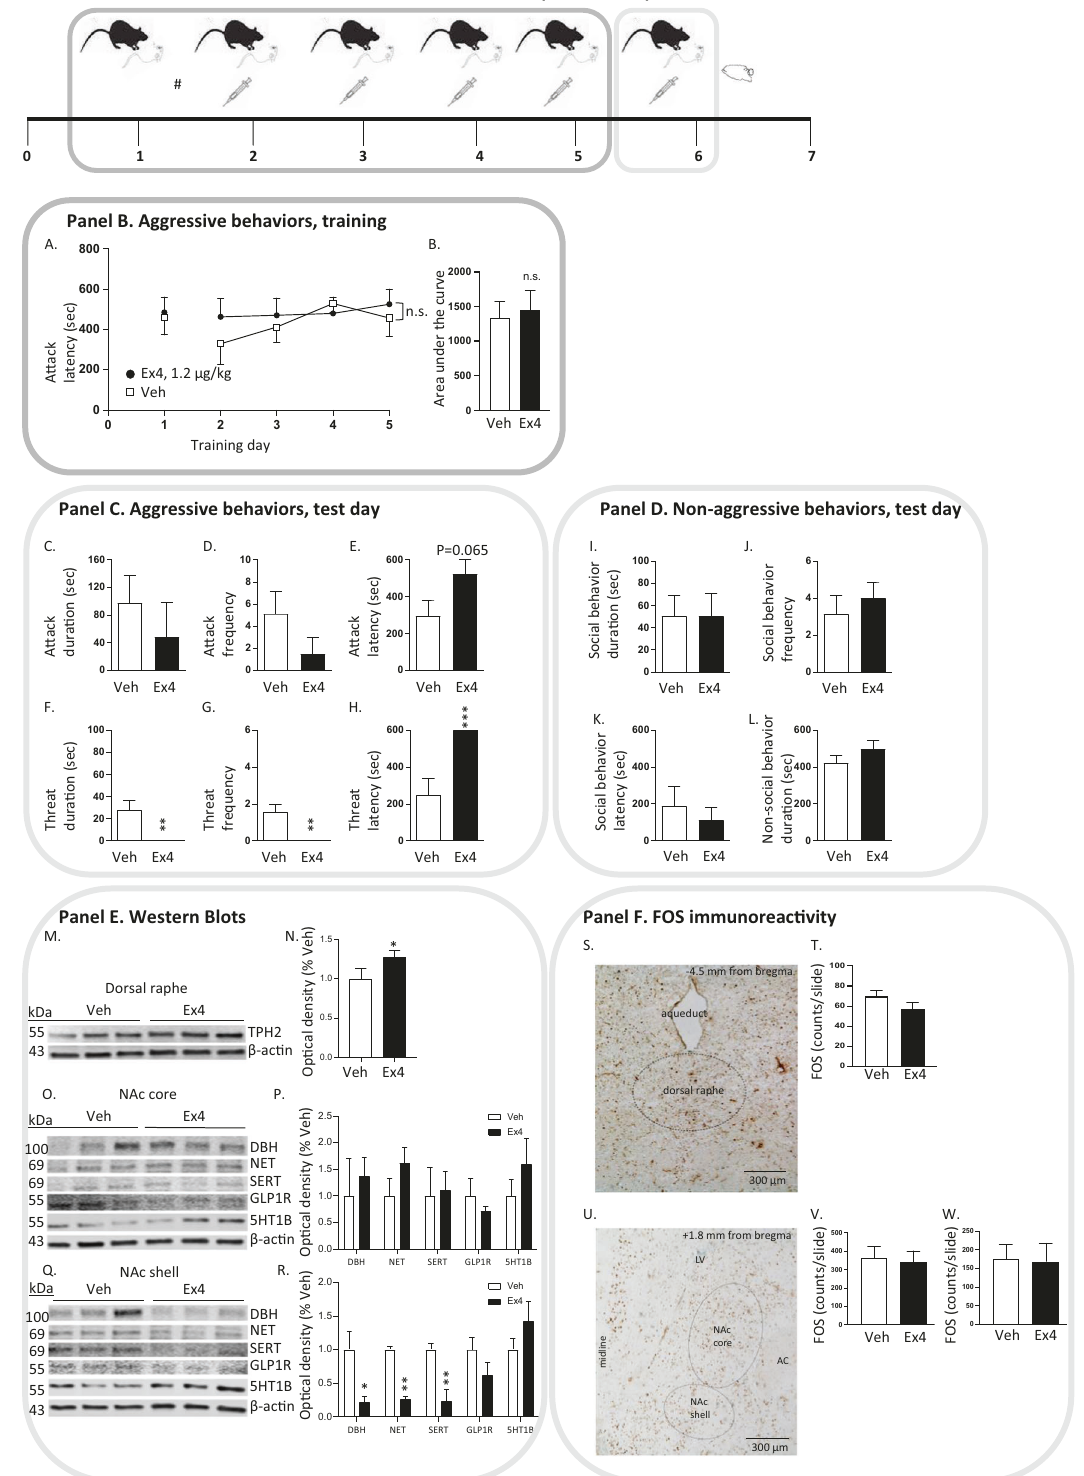
number of cells positive for FOS in this area (Fig. 3S, T, P = 0.1878). As Ex4 alters neurotransmission in NAc shell, we aimed to study the possibility that treatment alters neuronal activity by means of immunohistochemical studies (Fig. 3, Panel F). Similar to the western blot fi ndings, the low dose of Ex4 did not alter